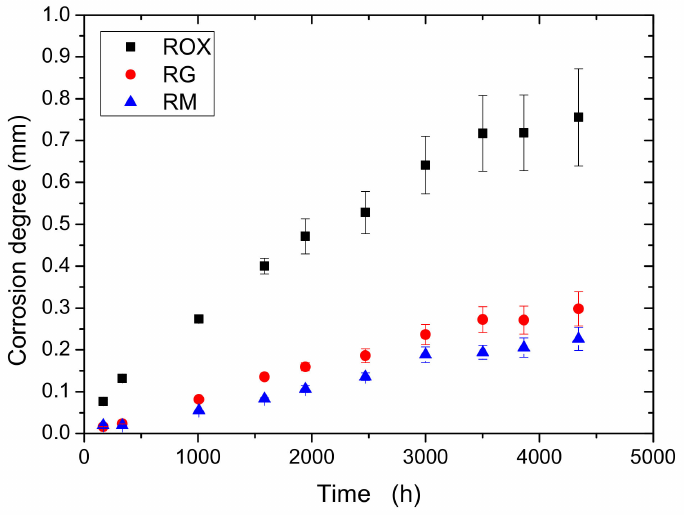
Figure 9. Evolution of the corrosion degree for X-cut panels immersed in NaCl solution at 35 ◦